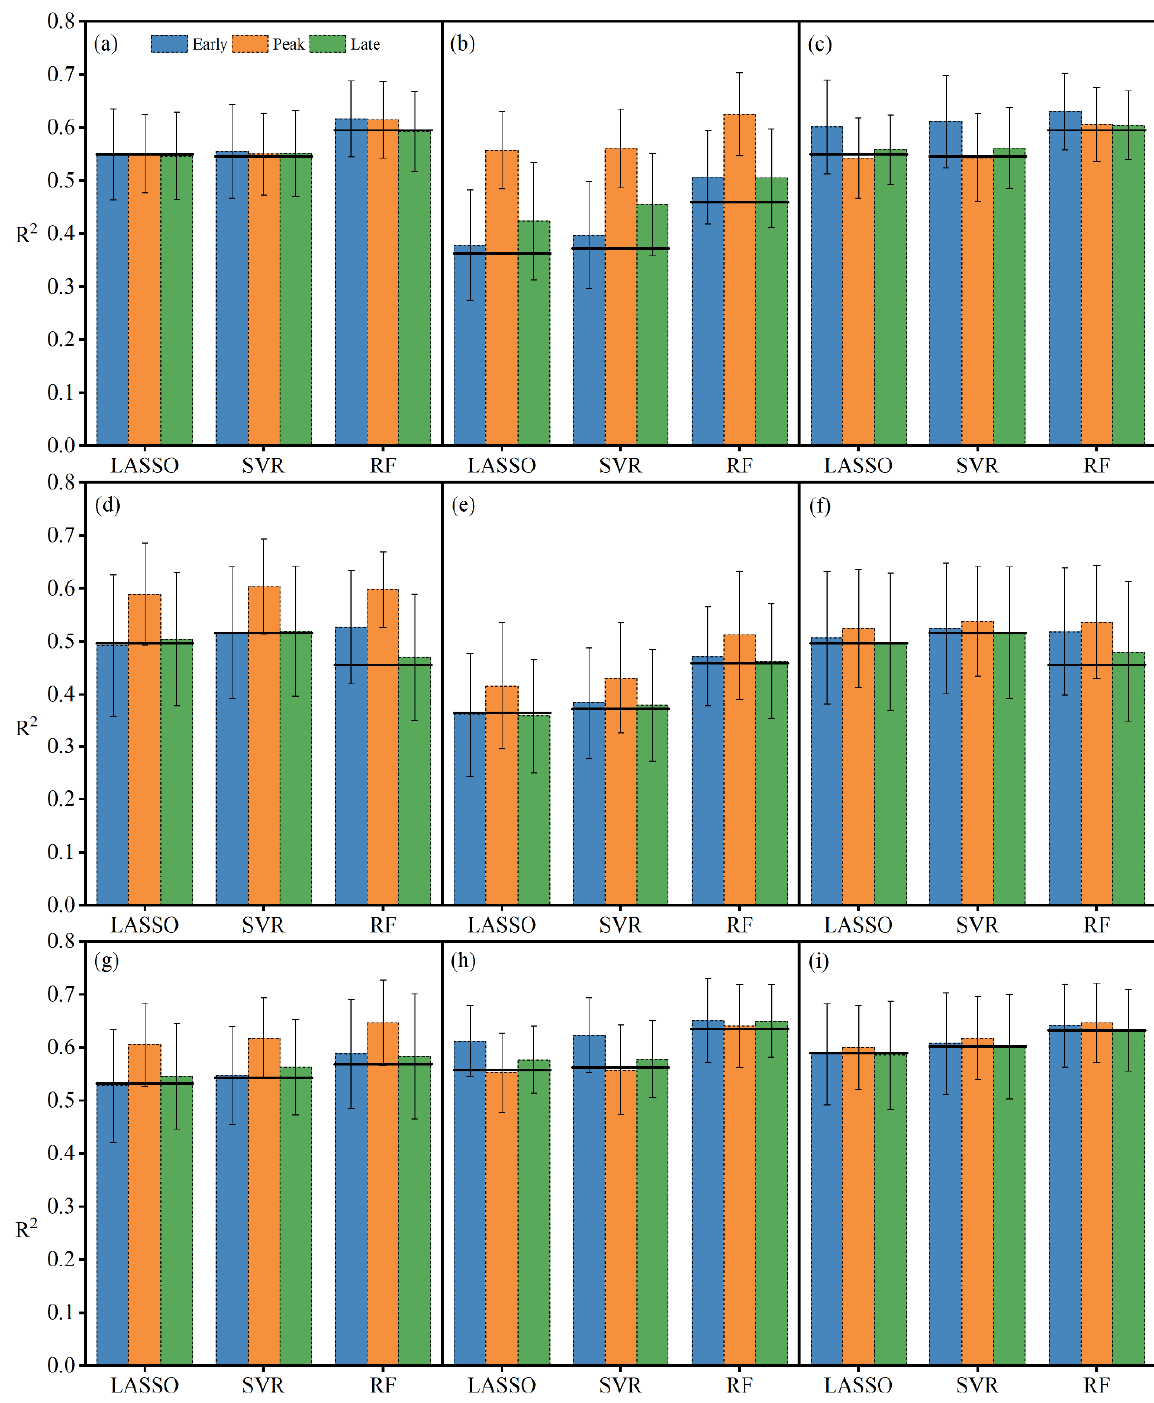
Figure 6. Model performance (predicted R 2 ) using one index or two indices for all months (i.e., the whole GS), but one index per stage of the GS. The GS was divided into three stages, namely early (GS early , May and June) (blue bars), peak (GS peak , July and August) (orange bars) and late (GS late , September and October) (green bars). ( a ) EVI of all months and LAI of per stage; ( b ) LAI of all months and EVI of per stage; ( c ) EVI of all months and LST of per stage; ( d ) LST of all months and EVI of per stage; ( e ) LAI of all months and LST of per stage; ( f ) LST of all months and LAI of per stage; ( g ) LAI + LST of all months and EVI of per stage; ( h ) EVI + LAI of all months and LST of per stage; ( i ) EVI + LST of all months and LAI of per stage. The solid line represents the performance of the benchmark model using only one index or two indices for all months as input data. Error bars are one SD of predicted R 2 derived from